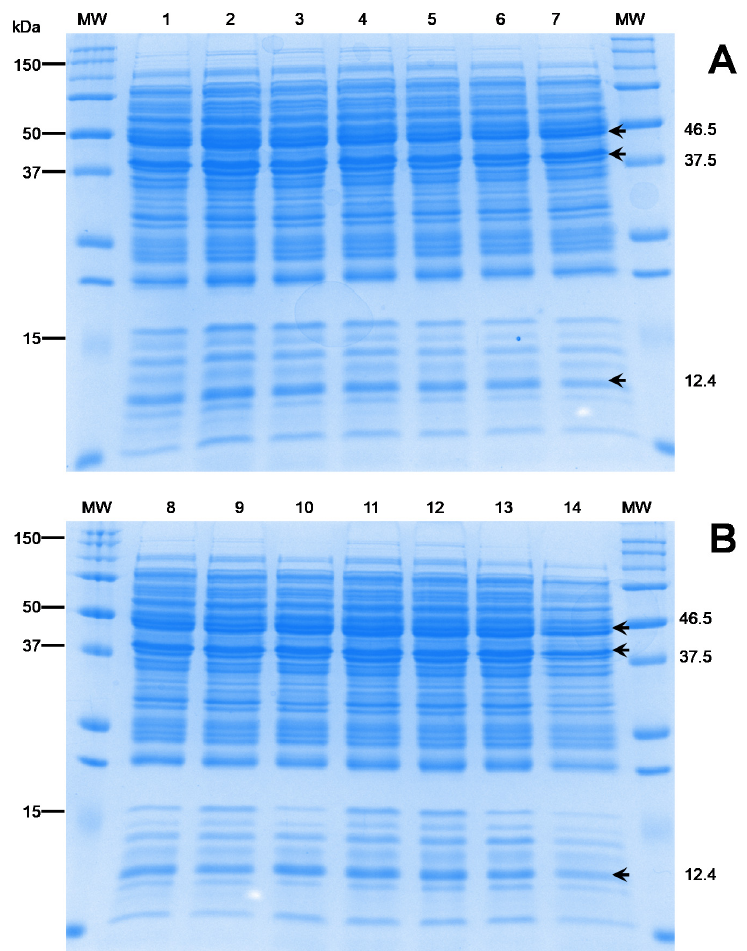
Figure 5. Electrophoresis protein profiles of 14 Mexican L. garvieae isolates. Lanes: MW, BioRad Precision Plus Protein TM ; ( A ) (1–7): 1, RC17-Lg01; 2, RC17-Lg02; 3, RC17-Lg03; 4, RC17-Lg04; 5, RC17-Lg05; 6, RC-Lg06; and 7, Mic16-Lg07 isolates. ( B ) (8–14): 8, Mic16-Lg08; 9, Mic16-Lg09; 10,